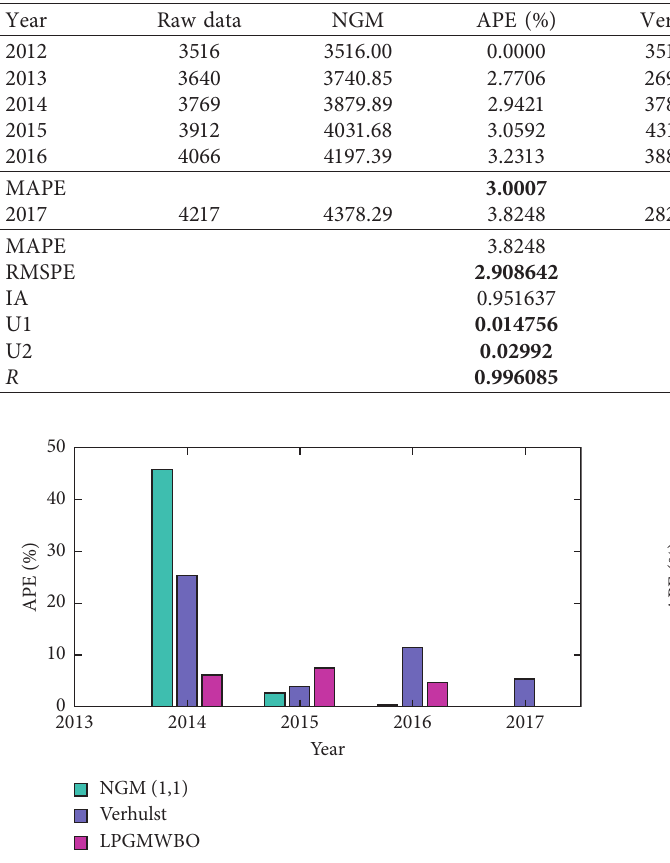
Figure 4: The APE of the three models for validation of Guangzhou